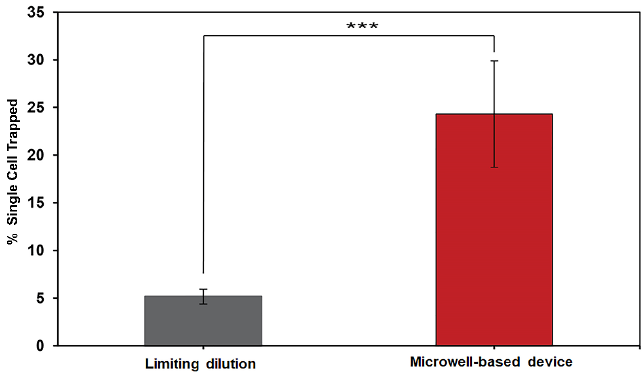
Figure 4. Comparison of the percentage of single-cell trapping using limiting dilution technique and the MBM device. Experimental data are reported as mean ± standard deviation ( n = 10). Means fol- lowed by the asterisk indicate a significant difference ( p < 0.001) using paired t -test.